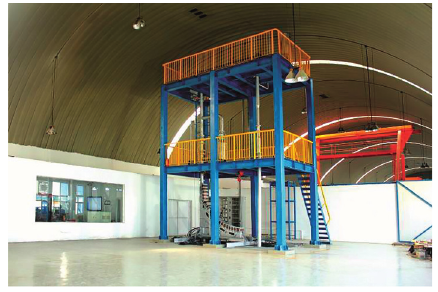
Figure 4: Overview of REVECT test